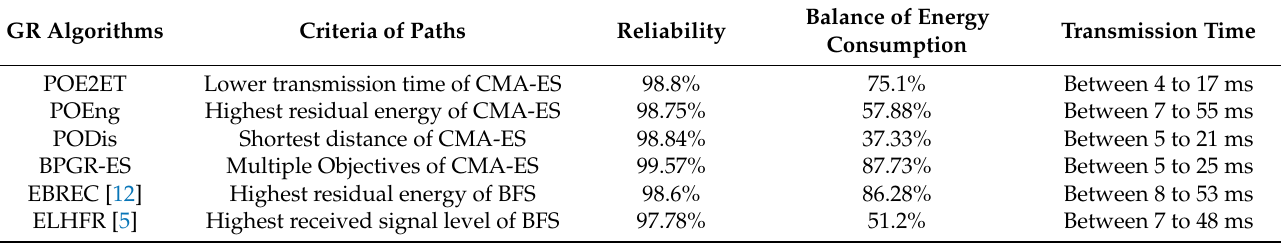
Table 3. Performance comparison of proposed best paths with GR